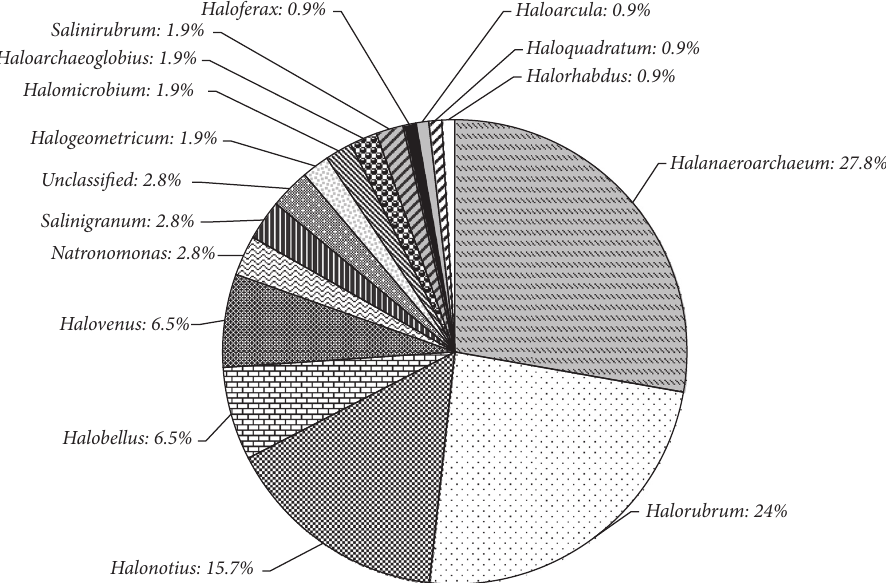
Figure 2: Genus affiliation of 16S rDNAs clones obtained from Pomorie salterns. Sequences were classified using BLAST search results and phylogenetic analysis in